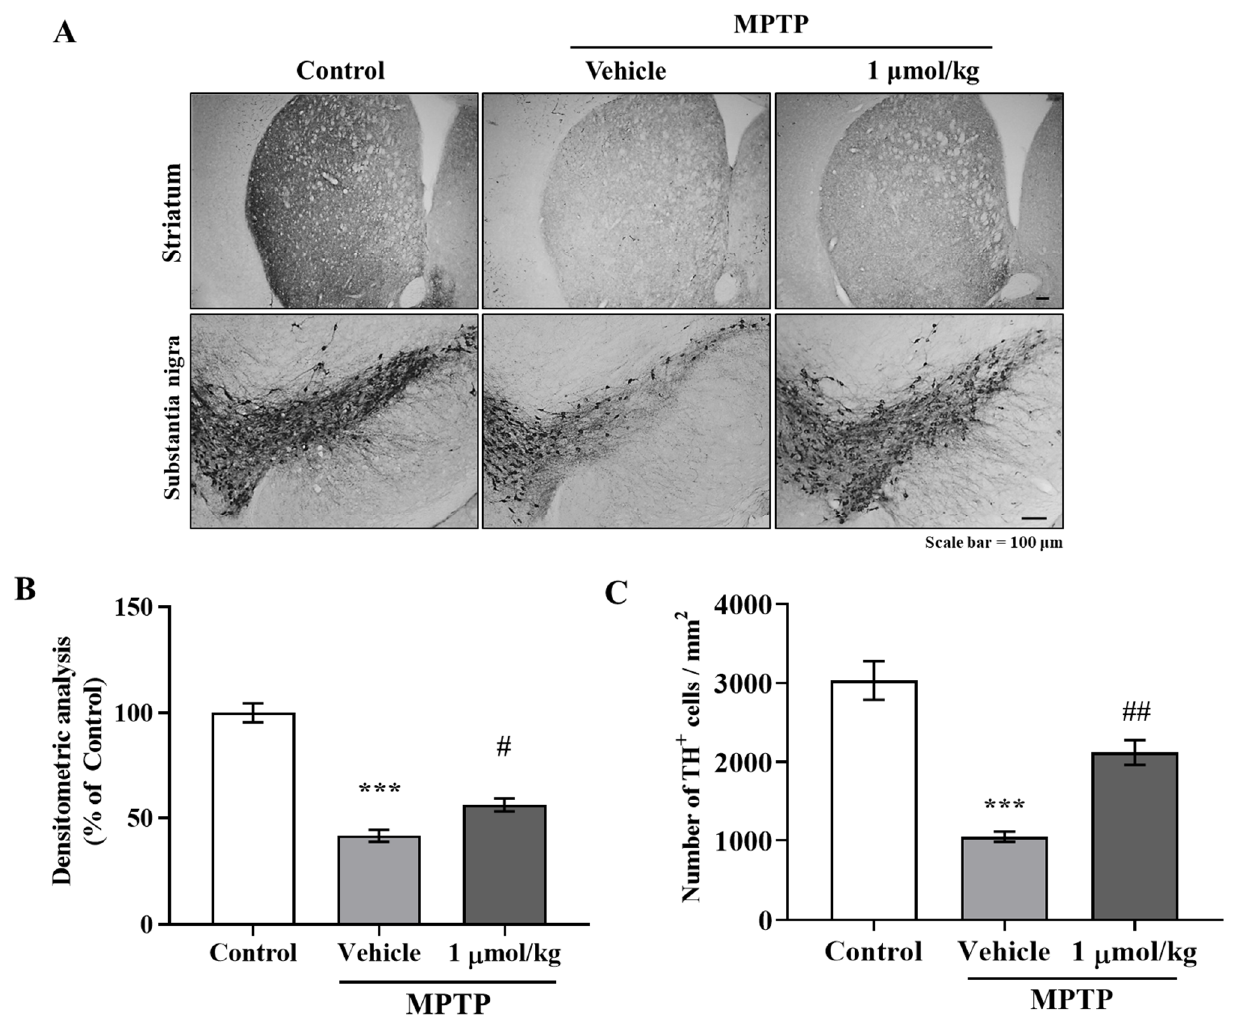
Figure 6. IAGIP prevented dopaminergic neuronal loss in the MPTP-induced mouse model of PD. ( A ) The neuroprotective effects of IAGIP on the nigrostriatal pathway were investigated immunohistochemically. Scale bar = 100 µm. ( B ) Densitometry was used to assess TH levels in STR. Values are means ± SEs ( n = 5 – 6 mice/group). *** p < 0.001 vs. vehicle-treated controls and # p < 0.05 vs. MPTP-treated controls. ( C ) TH-positive dopaminergic neurons in the SN were counted, and results are presented as means ± SEs ( n = 5 – 6 mice/group). *** p < 0.001 vs. vehicle-treated controls and ## p < 0.01 vs. MPTP-treated controls.